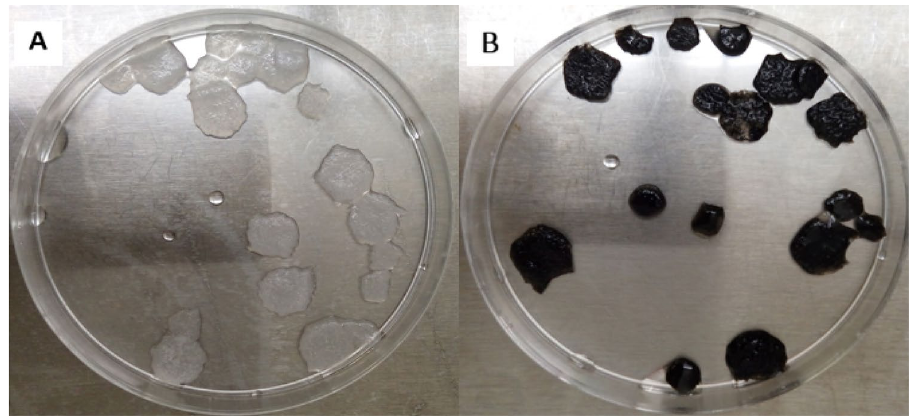
Figure 1. Macroscopic structure of ( A ) Col and ( B ) Col-rGO scaffolds. Graphene coating darkened the scaffolds color without any change in stability.